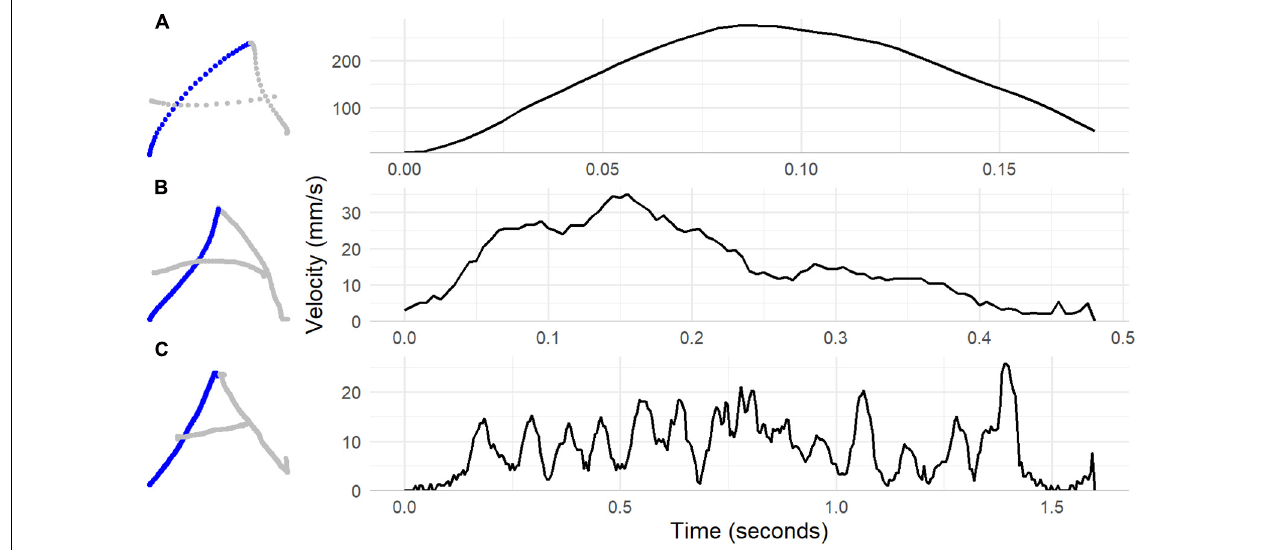
FIGURE 1 | Pen trajectory and velocity profiles for the first feature of the letter A (shown in blue) written by an adult in panel (A) , and two first-grade children in panel (B,C)